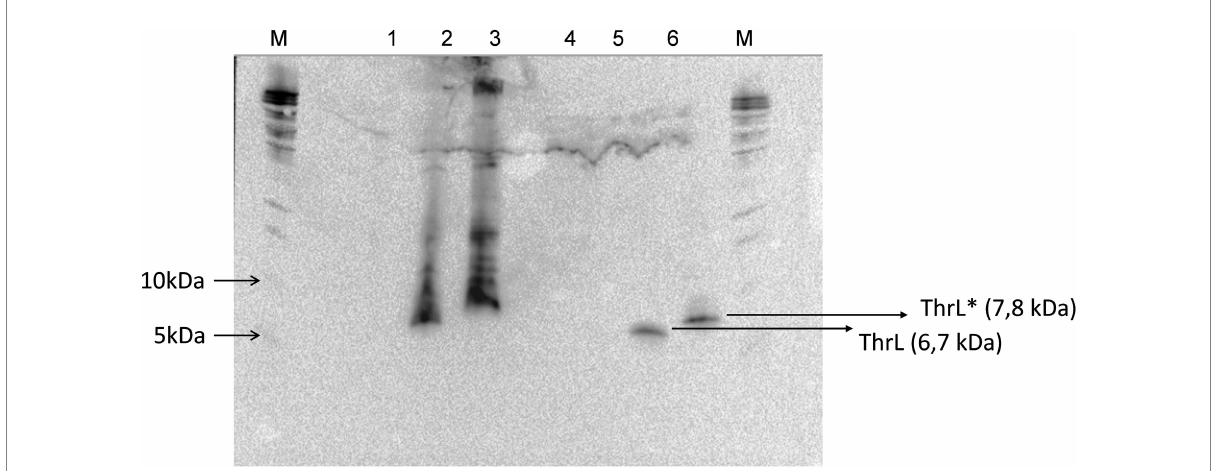
FIGURE 2 Western blot analysis of His-tagged ThrL and ThrL* protein with anti-His antibodies. Lanes 1, 2 and 3 corresponds to cell lysate of E. coli transformed with pET28(+), pET28(+) carrying thrL and pET28(+) carrying thrL* . Lanes 4, 5 and 6 are same samples after purification on an affinity Co 2+ column. M means Marker.